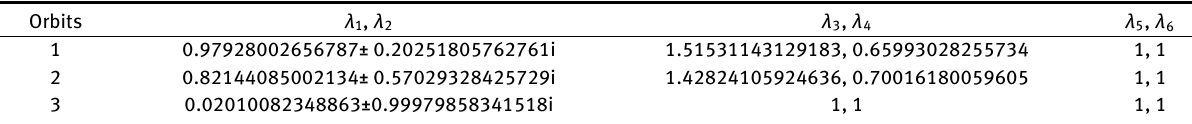
Table 5. Floquet multipliers of periodic orbits in the potential of Kalliope Orbits λ 1 , λ 2 λ 3 , λ 4 λ 5 , λ 6 0.97928002656787±